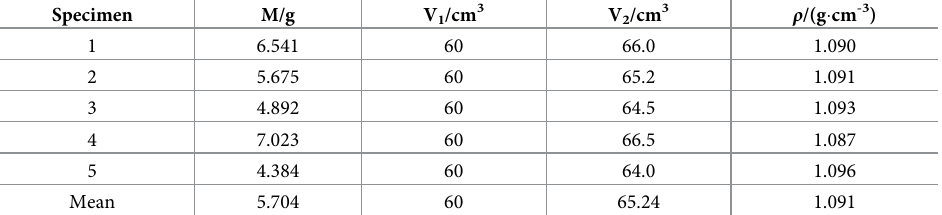
Table 6. Density test data of black fungus.